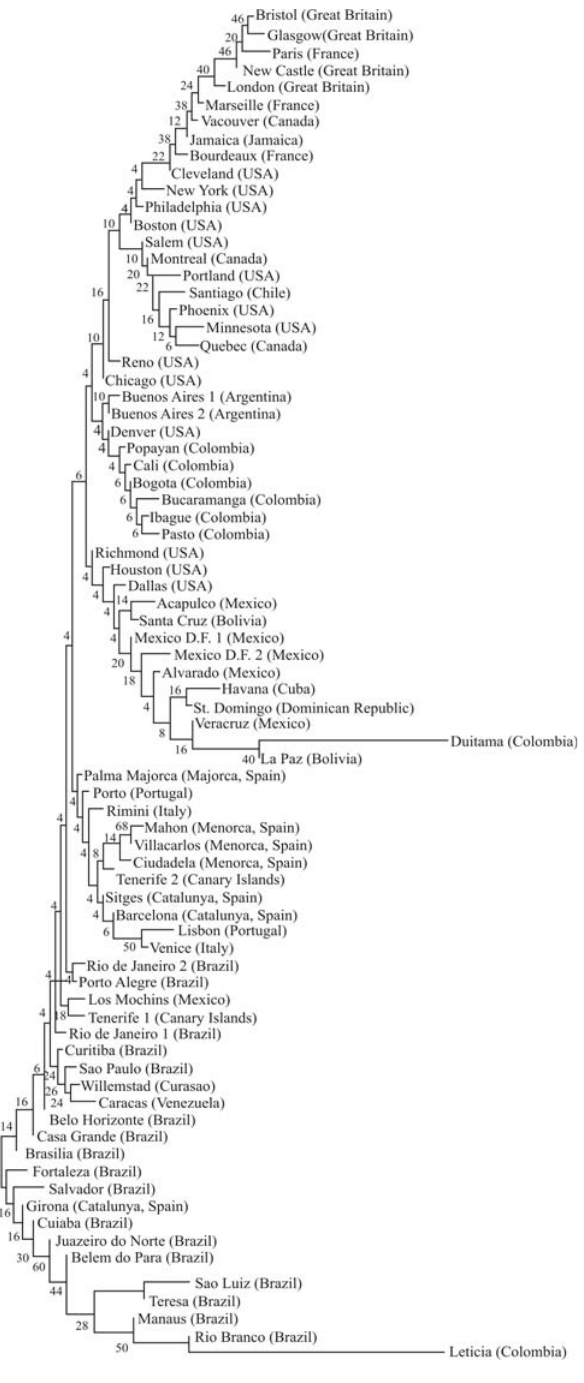
Figure 2 - Phenetic analysis of 78 Latin American, North American and European cat populations, estimated by using the neighbor-joining algo- rithm with the DA genetic distance (Nei et al. , 1983). Numbers on the tree nodes represent bootstrap